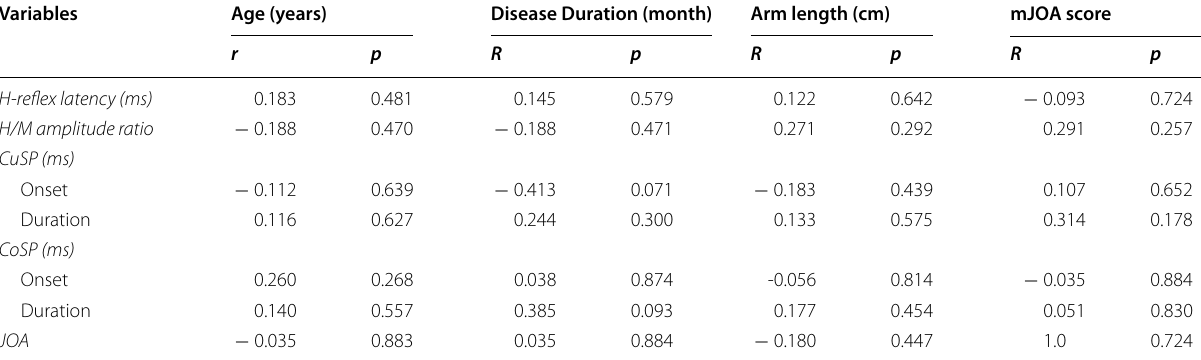
CuSP cutaneous silent period, CoSP cortical silent period, mJOA Japanese Orthopedic Association